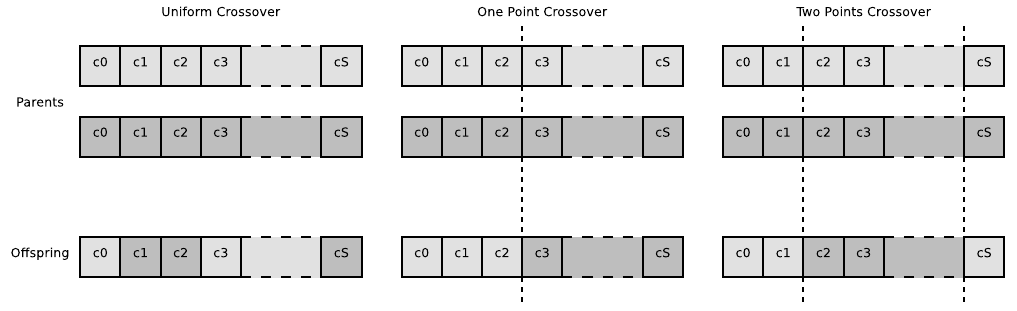
Figure 3. Examples of crossover